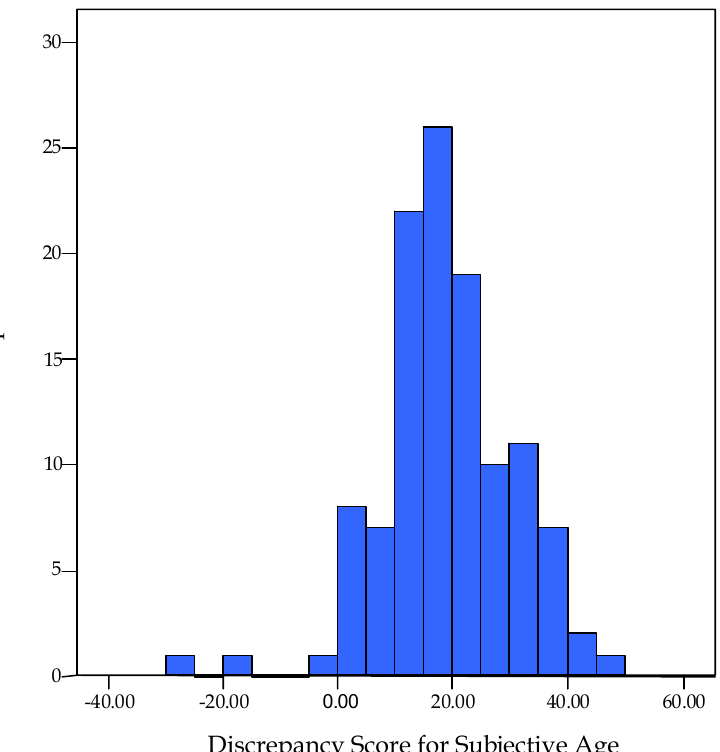
Figure 1 . Age Discrepancy Scores for Subjective Age: Actual Age minus Age ‘Feel